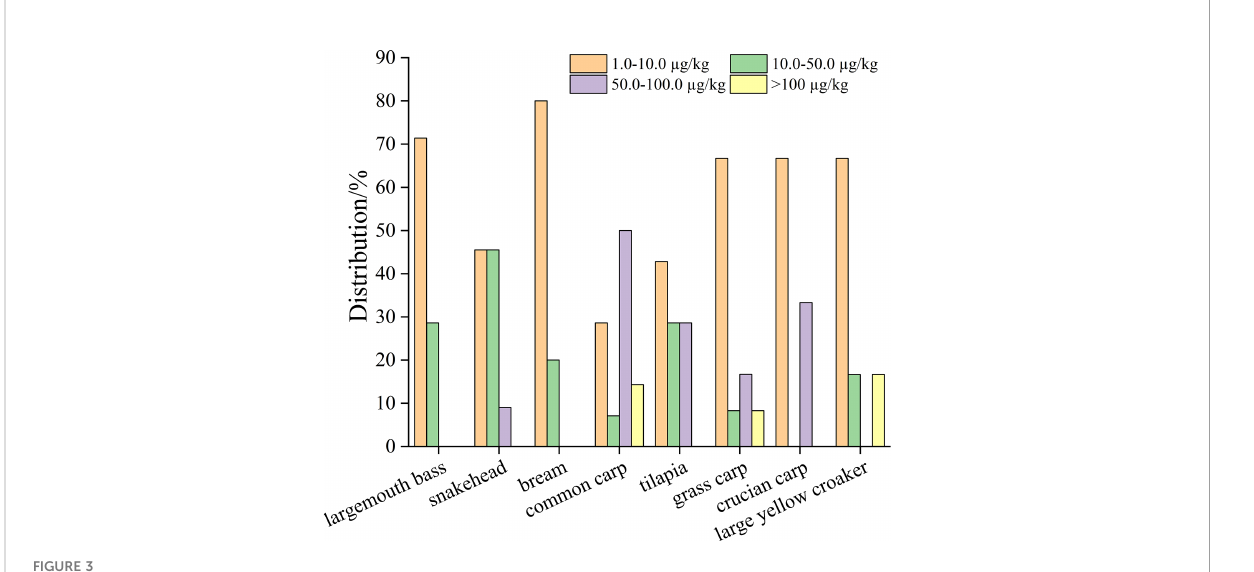
FIGURE 3 Distributions of concentration in different aquatic